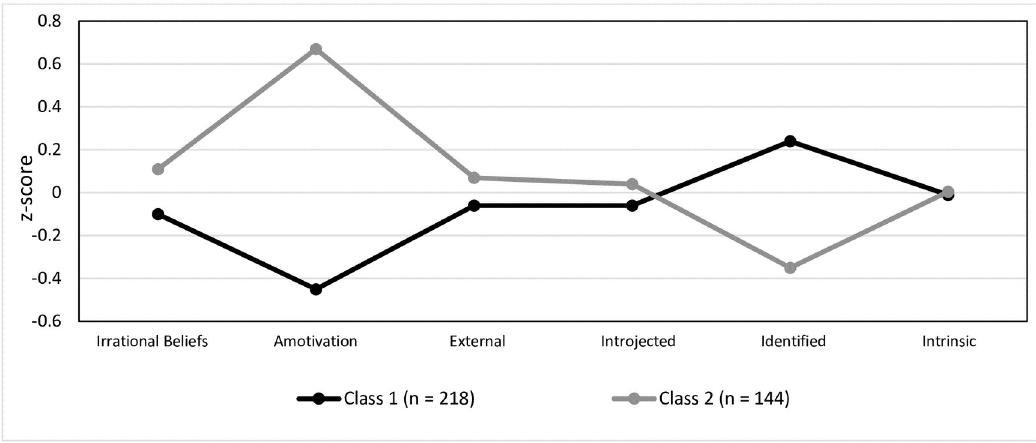
Fig 1. Latent profile analysis. Estimates of the variables for the two latent profile analysis (LPA) classes in Study 1.